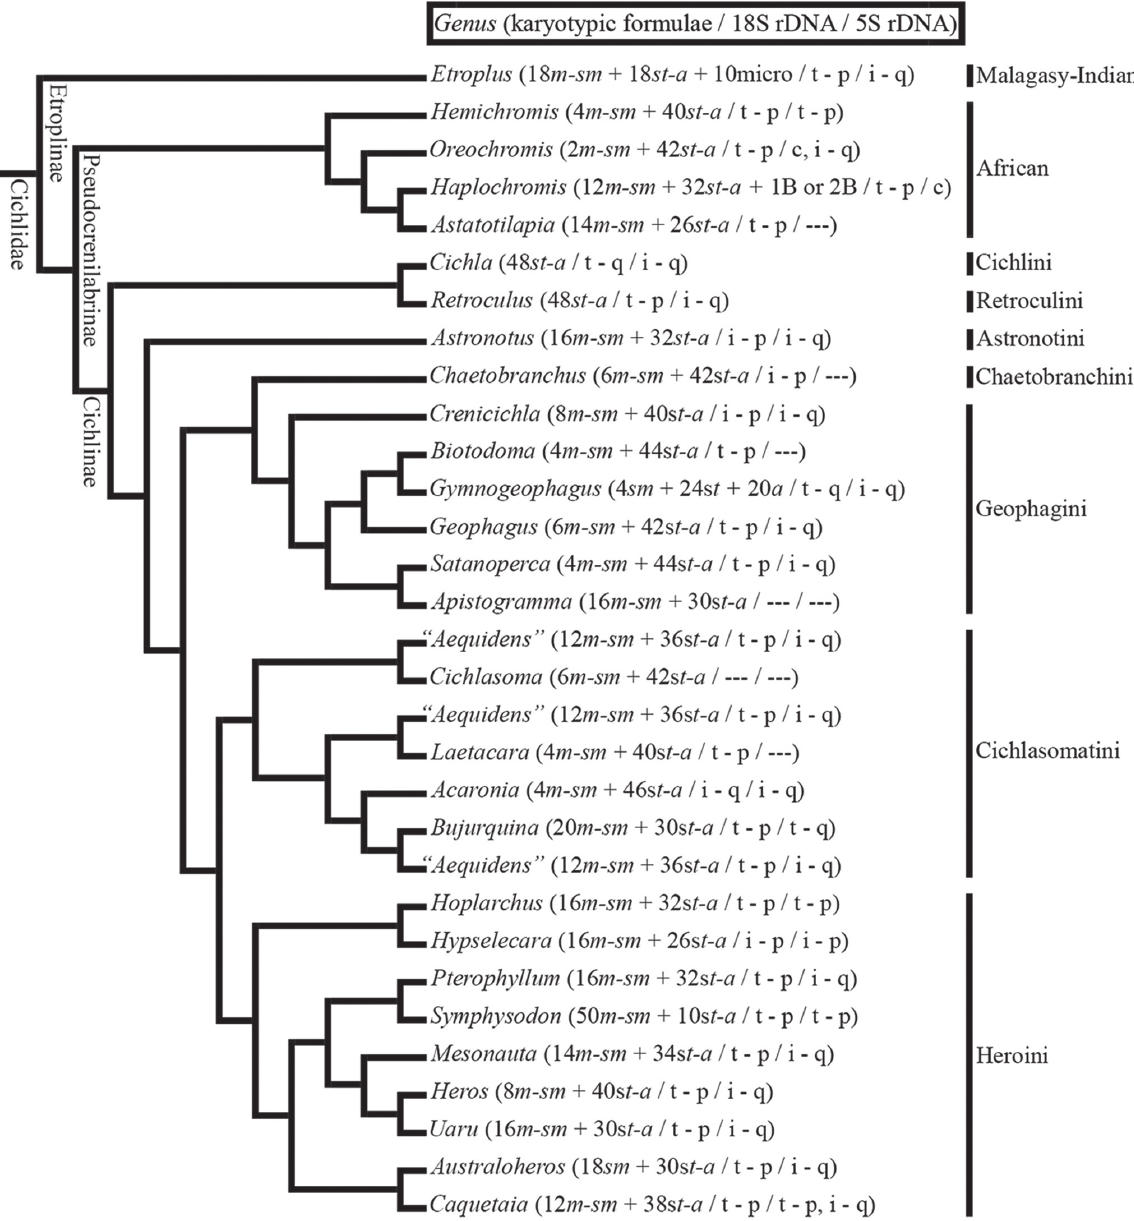
Fig. 3. Phylogeny of Malagasy, Indian, African and Neotropical cichlids showing the karyotypic formulae, 18S and 5S rDNA of a species possessing the most common cytogenetic data for each genus. m = metacentric; sm = submetacentric; st = subtelocentric; a = acrocentric; p = short arm; q = long arm; c = centromeric position; t = terminal position; i = interstitial position. The phylogeny is modified from Smith et al .